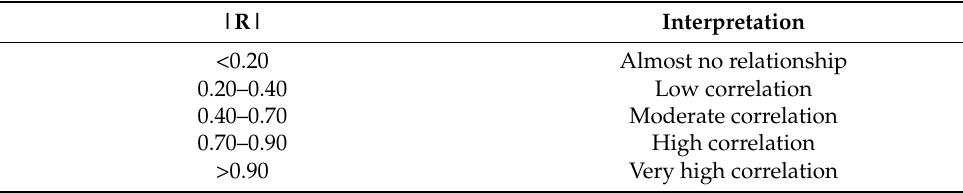
Table 1. Guilford’s interpretation of the magnitude of significant correlations